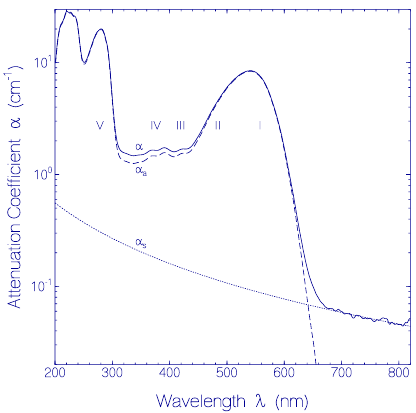
Figure 1. Attenuation coefficient spectrum of a fresh CaRh sample in pH 7.3 HEPES/MOPS buffer. Solid curve: attenuation coefficient spectrum α ( λ ) measured after sample centrifugation (4400 rpm for 15 min at 4 °C). Dotted curve: approximate scattering contribution α s ( λ ). Dashed curve: approximate absorption coefficient spectrum α a ( λ ). The numbers I – V indicate different excitation transitions.